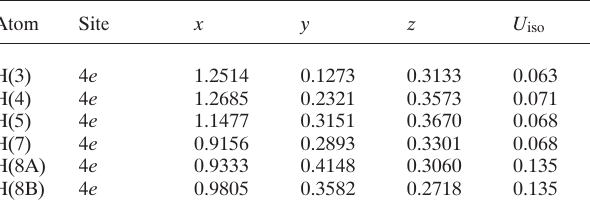
Table 2. Atomic coordinates and displacement parameters (in Å 2 )